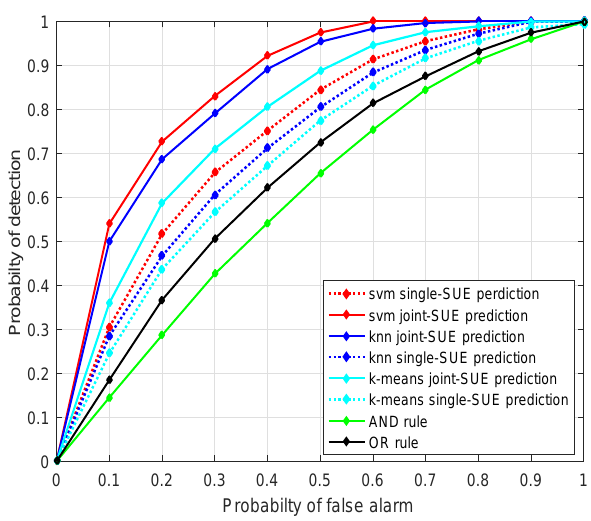
Figure 10. Receiver operating characteristics (ROC) of different sensing